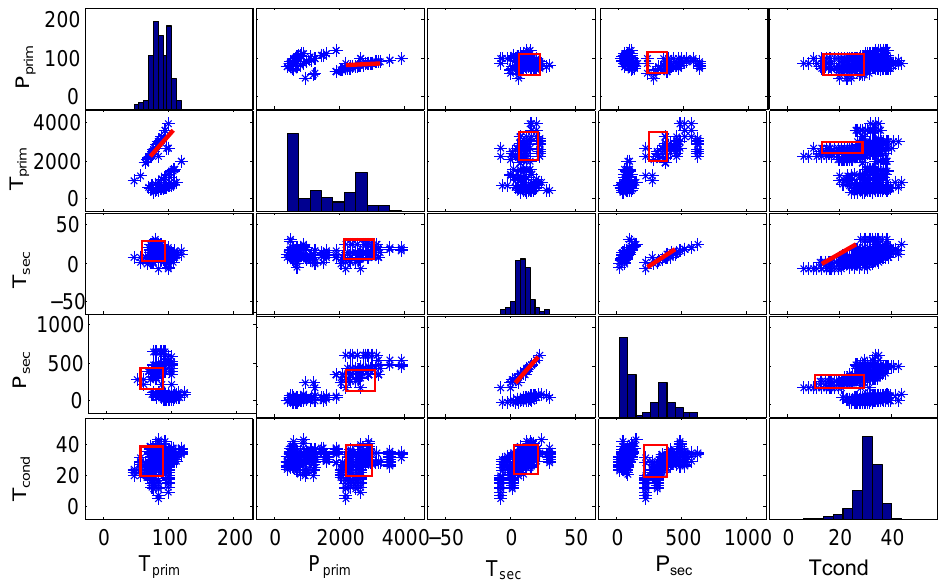
Figure 11. Scatter plot matrix of the input data regarding operating conditions. Rectangles and lines show the range of optimum